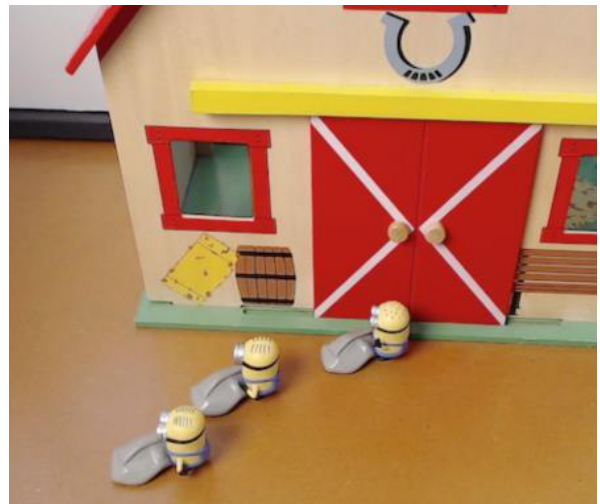
Figure 2. Image of the Last Scene of a Distributive Scenario, in Which Each of Three Minions Pushes Its Own